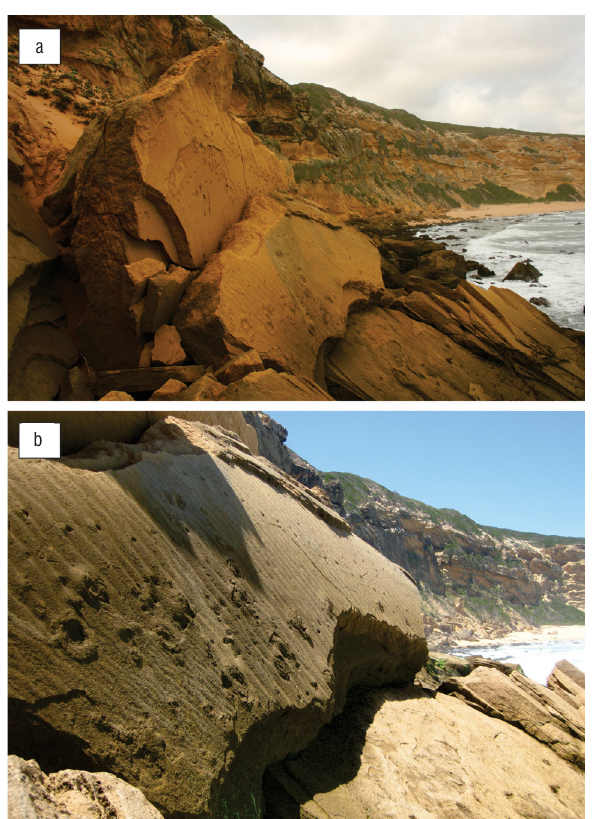
Figure 3: (a) Roberts Rock in 2009, after its separation. (b) The seaward portion of Roberts Rock in 2009 in good light conditions showing elephant and artiodactyl trackways.